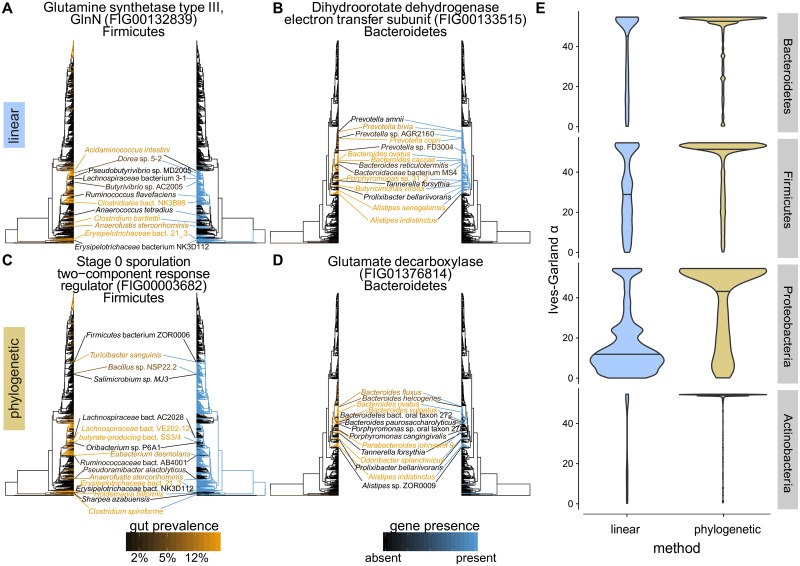
Examples of hits from standard linear (blue highlights) and phylogenetic (orange highlights) models.In each panel, the tree on the left is colored by species prevalence (black to orange), while the tree on the right is colored by gene presence-absence (blue to black). Selected species are displayed in the middle; lines link species with the leaves to which they refer. The color of the line matches the color of the leaf. A-B) The standard model recovered hits that matched large clades but without recapitulating fine structure. C-D) The phylogenetic model recovered associations for which more of the fine structure was mirrored between the left-hand and right-hand trees, as exemplified by the species labeled in the middle. E) Violin plots of Ives-Garland α, a summary of the rate of gain and loss of a binary trait across a tree, for genes significantly associated with prevalence in the standard (left, blue) and phylogenetic (right, orange) linear models. Horizontal lines mark the median of the distributions. The phylogenetic (orange) and standard linear (blue) models were significantly different for each phylum (Wilcox test for Bacteroidetes: 8.2 × 10−41; Firmicutes: 7.6 × 10−279; Proteobacteria: 1.8 × 10−235; Actinobacteria: 9.0 × 10−133).